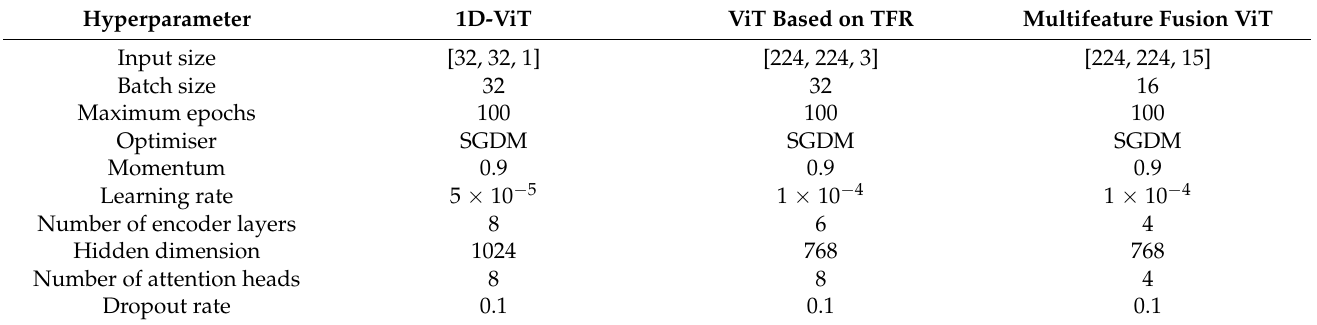
Table 2. Structure and hyperparameter selection for the multifeature fusion ViT model and two benchmark models.